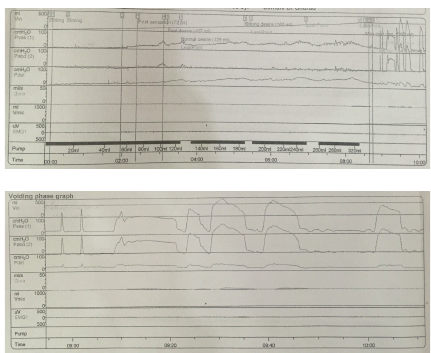
Figure 2: Pressure-flow study report: